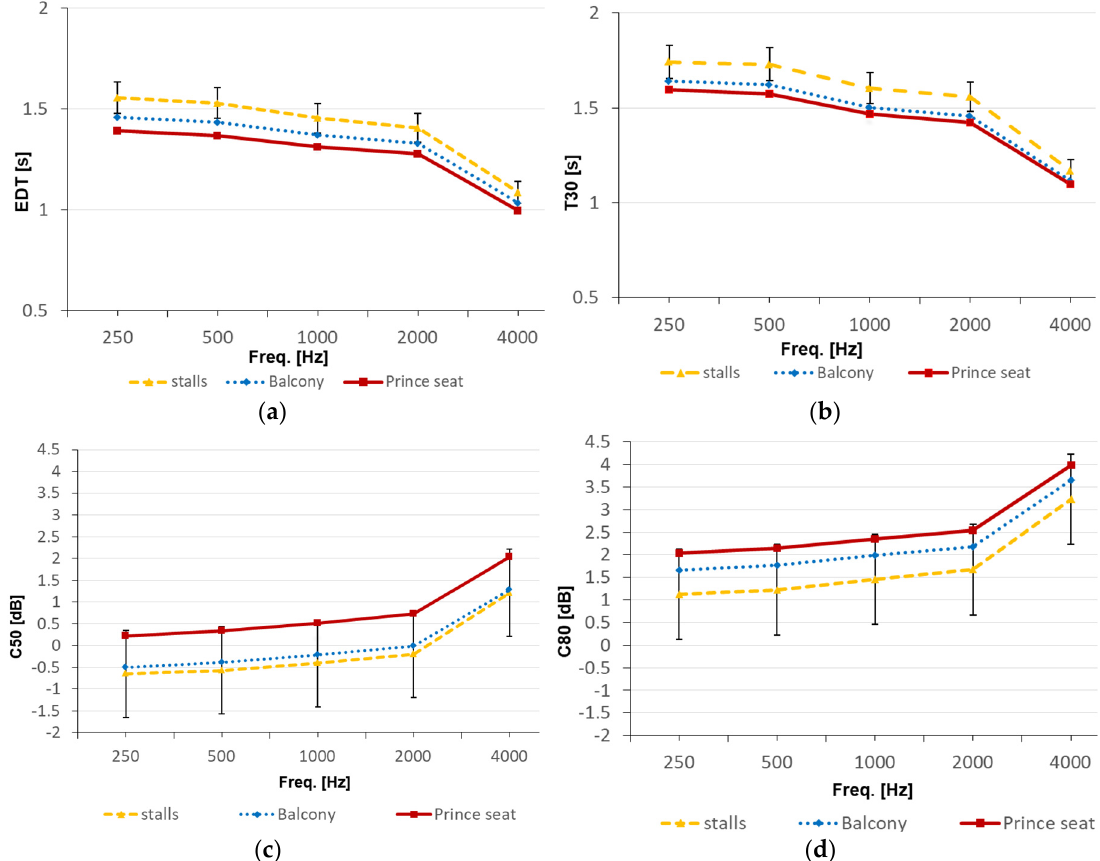
Figure 13. Simulated acoustic parameters (( a ) EDT, ( b ) T30, ( c ) C50, and ( d ) C80) for the theatre with the audience in the main hall. The values are subdivided into three groups (stalls, Prince’s box, and gallery) and averaged over the corresponding receivers. The error bars (Just Noticeable Difference, JND) are reported for receivers in the stalls.